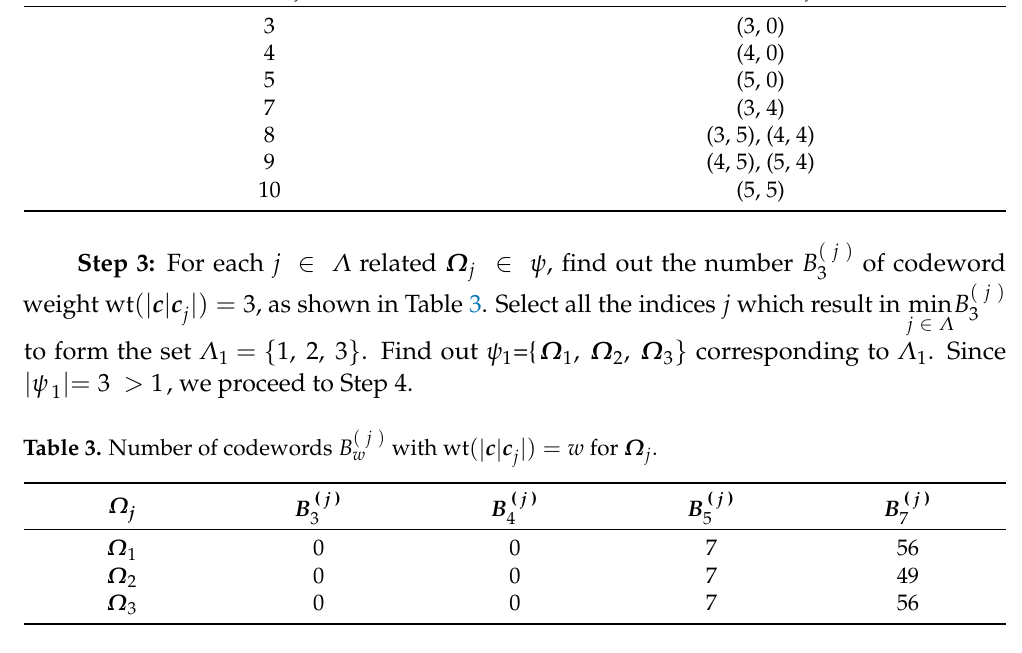
Table 2. Codeword weight wt ( | c | c